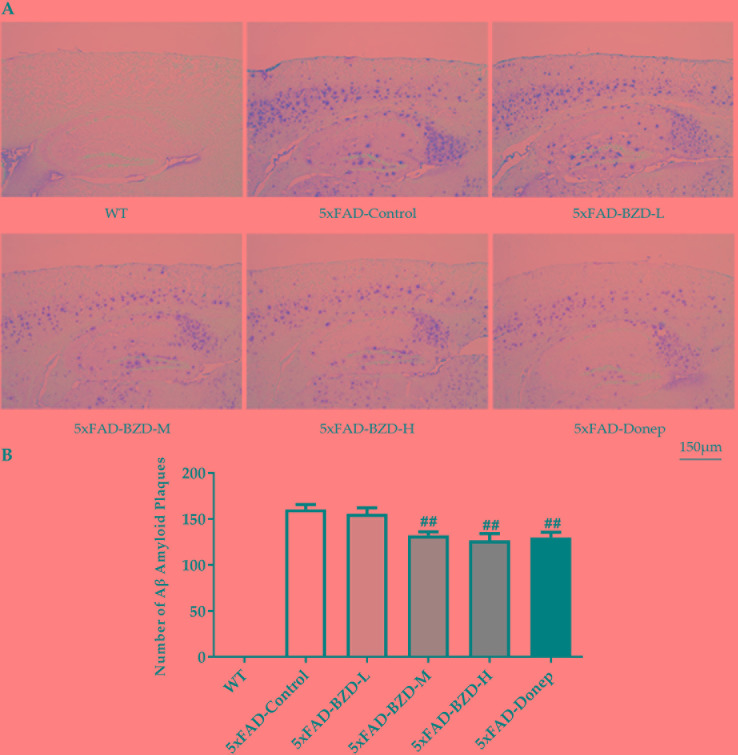
BZD Reduces Aβ Deposition. (A) Immunohistochemistry analysis of Aβ plaques in the cortex and hippocampus of 5xFAD Mice (5xFAD-Control, 5xFAD-BZD-L, 5xFAD-BZD-M, 5xFAD-BZD-H and 5xFAD-Donep) and wild type (WT) littermates. Representative images of Aβ plaques; Scale bar, 150 µm. (B) Quantification of Aβ plaques in A. Data are expressed as the mean ± SD from 6 mice per group. ##P < 0.01 compared with 5xFAD-Control group, One-Way ANOVA.